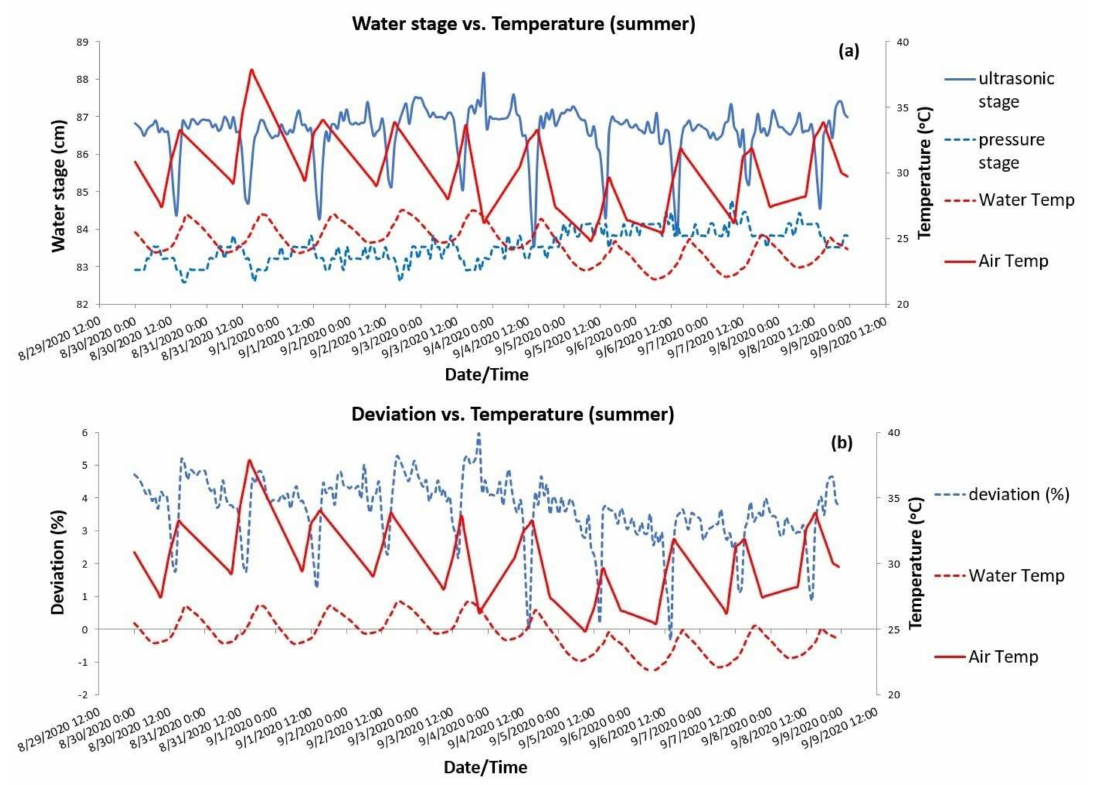
Figure 6. A selected 10-d summer period of observation at Pikrodafni stream: ( a ) ultrasonic and pressure water stages vs. temperatures and ( b ) deviations (%) of pressure stages from ultrasonic stages vs.